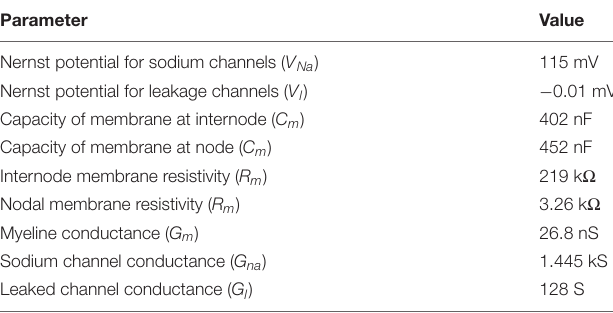
ensheathed by myelin) and nodes of Ranvier (ionic channels). TABLE 1 | Parameters of the modified CRRSS